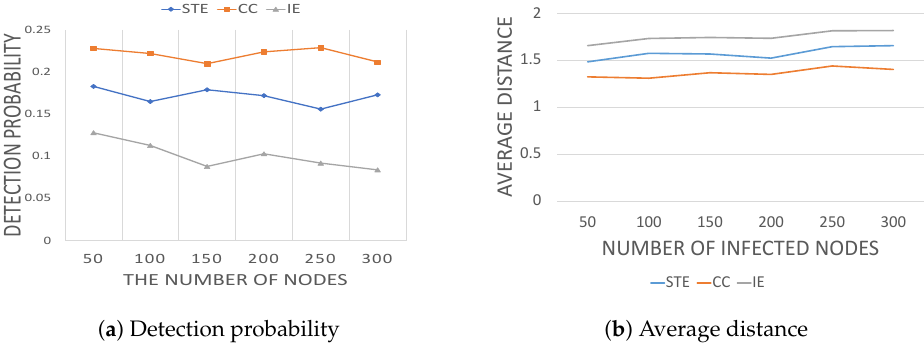
Figure 4. Performance of STE, CC, and IE in general